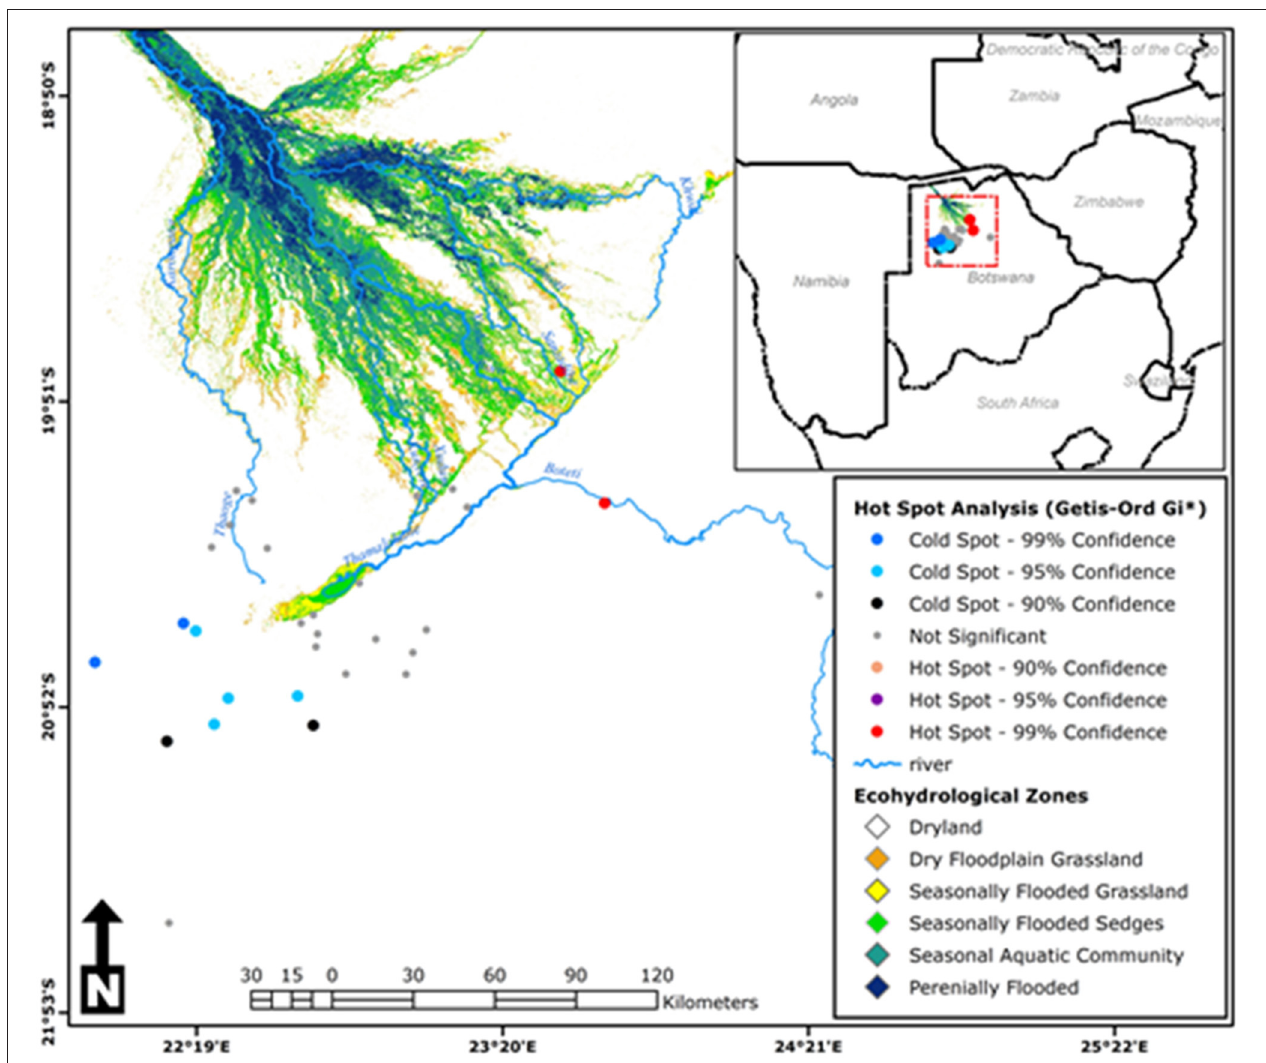
FIGURE 6 | Hot-spot analysis results for the late-hot-dry season showing cluster patterns of tick counts between neighboring crushes across the study area [Source: Adapted from Murray-Hudson et al. ( 52), Wolski et al. (53), and Inman and Lyons (54) and Landsat 5, 7, and 8: 1990–2019;